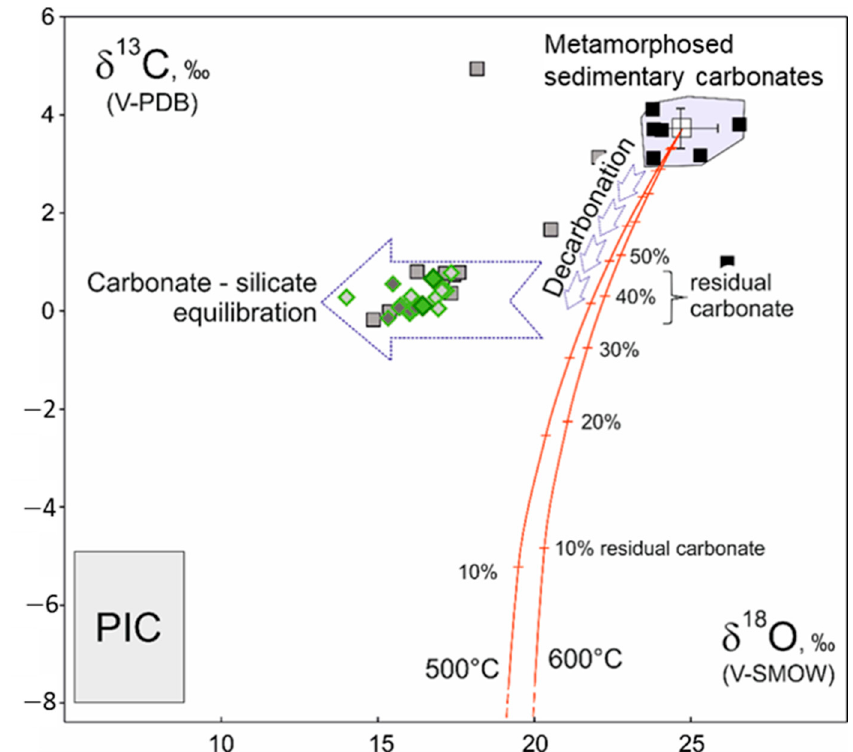
Figure 8. Scheme of decarbonation and carbonate–silicate equilibration processes, which took place during Chick intrusion formation. The decarbonation lines (red solid lines) were calculated using the fractionation factors “calcite-CO 2 ” for 500 and 600 °C [43,44]. The arrow shows the direction of partial isotope exchange of carbonate with igneous silicate melt or hot silicate rock. PIC is the primary igneous carbonatites box according to [42]. The symbols are the same as in Figure 6.